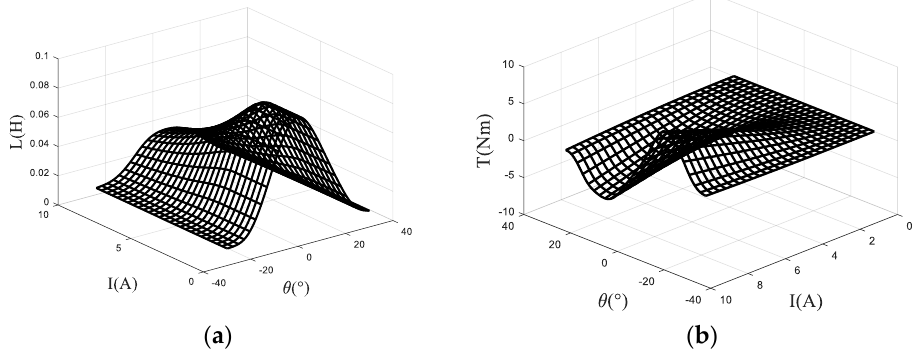
Figure 4. ( a ) inductance relative to the rotor angle and current ( b ) torque relative to the rotor angle and current.